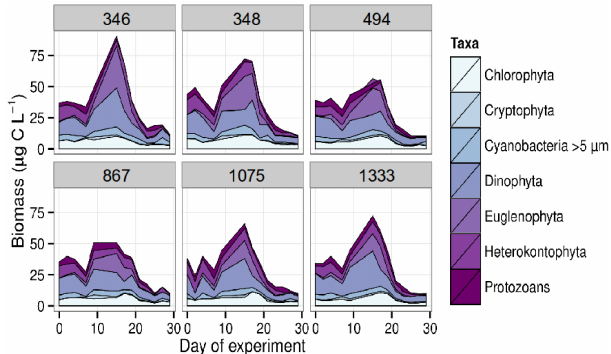
Figure 1. Calculated biomass after cell counts of the main plankton taxonomic groups in the different CO 2 treatments between days 1 and 29. Each treatment is labelled with the average f CO 2 level of the entire experimental period